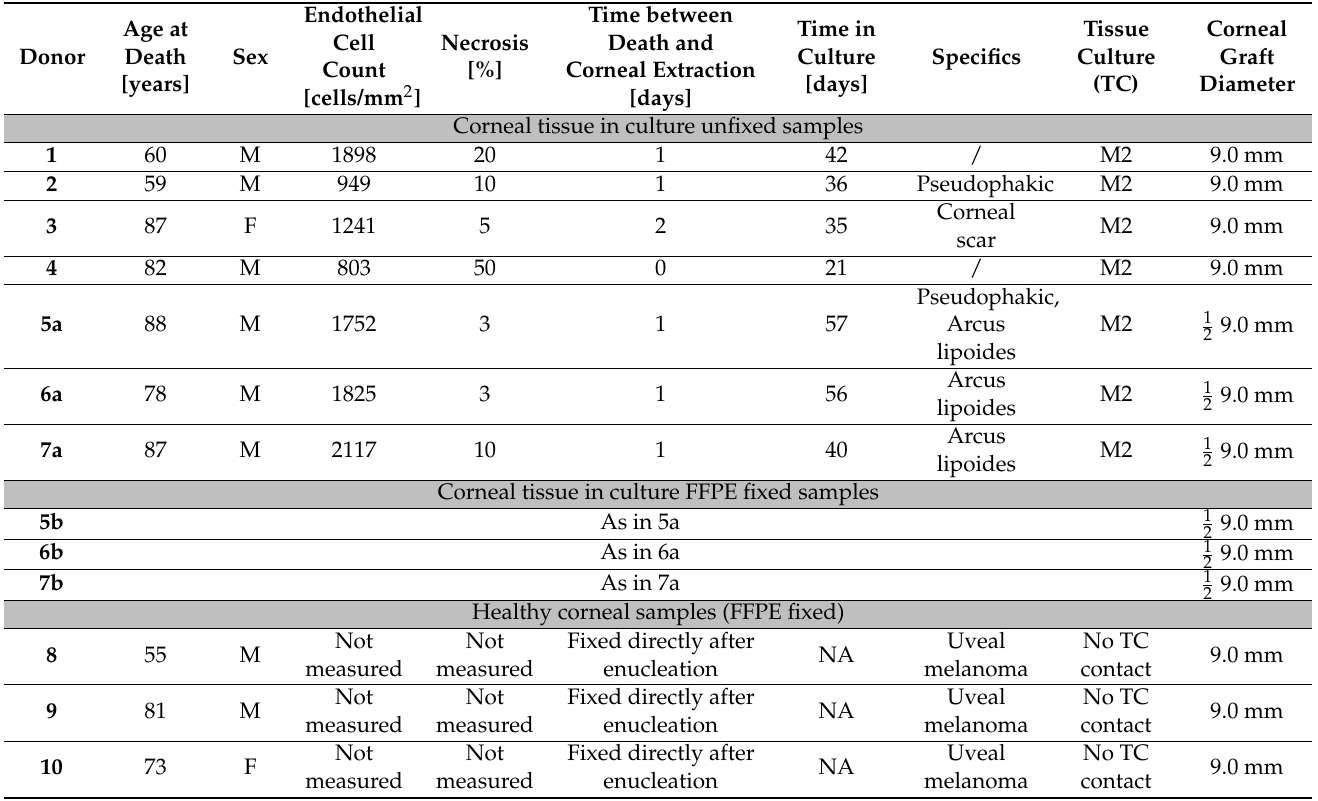
Table 1. Donor details. Samples 1–7 originate from the eye bank; these specimens have been maintained in culture; samples 5b–7b were used to assess the effect of FFPE embedding; samples 8–10 are corneas fixed immediately after enucleation and were not stored in tissue culture